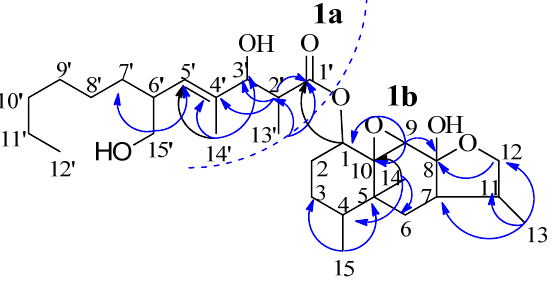
Figure 2. The fragments and selected HMBC correlations of 1